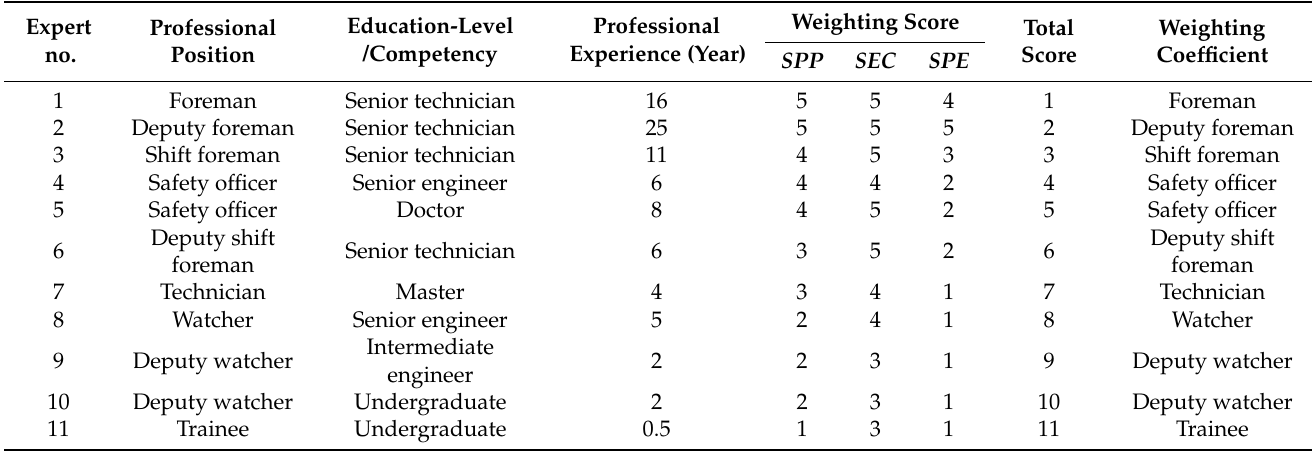
Table 4. The situation of the expert group and the weighting of experts.